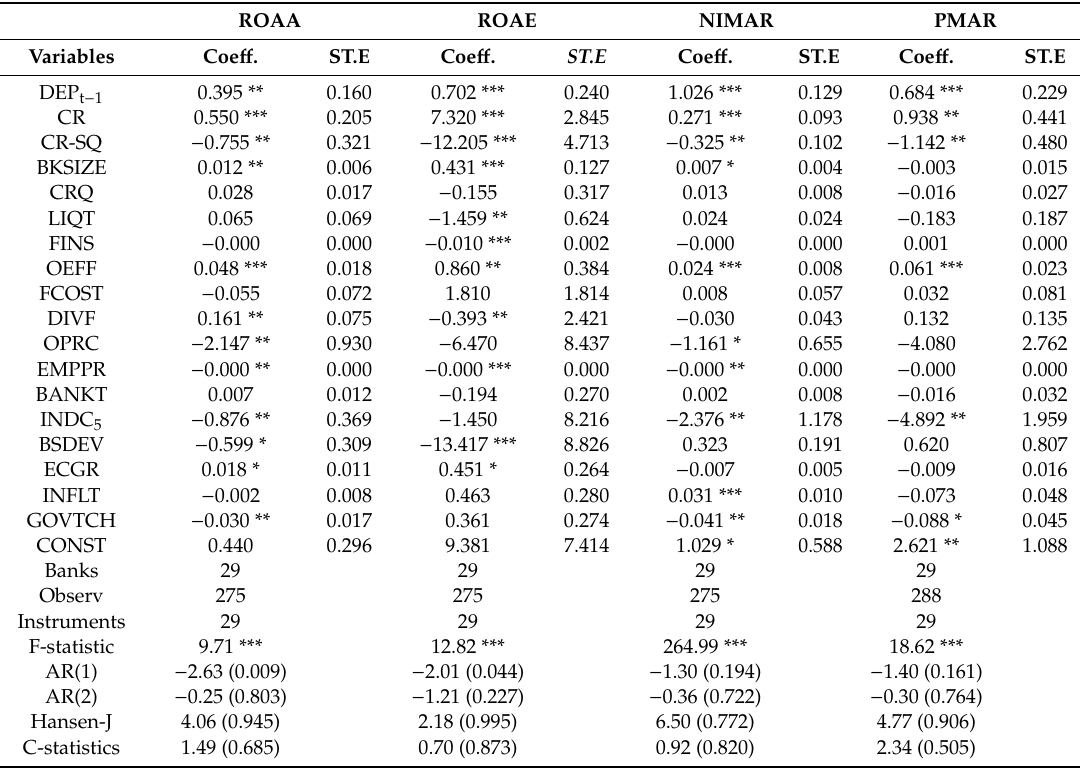
Table 8. The Capital adequacy ratio (CAR) and